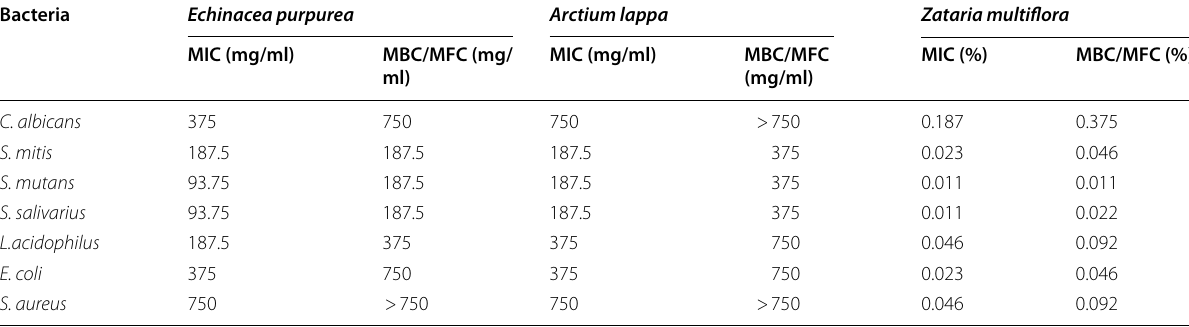
All samples were tested three times in independent experiments